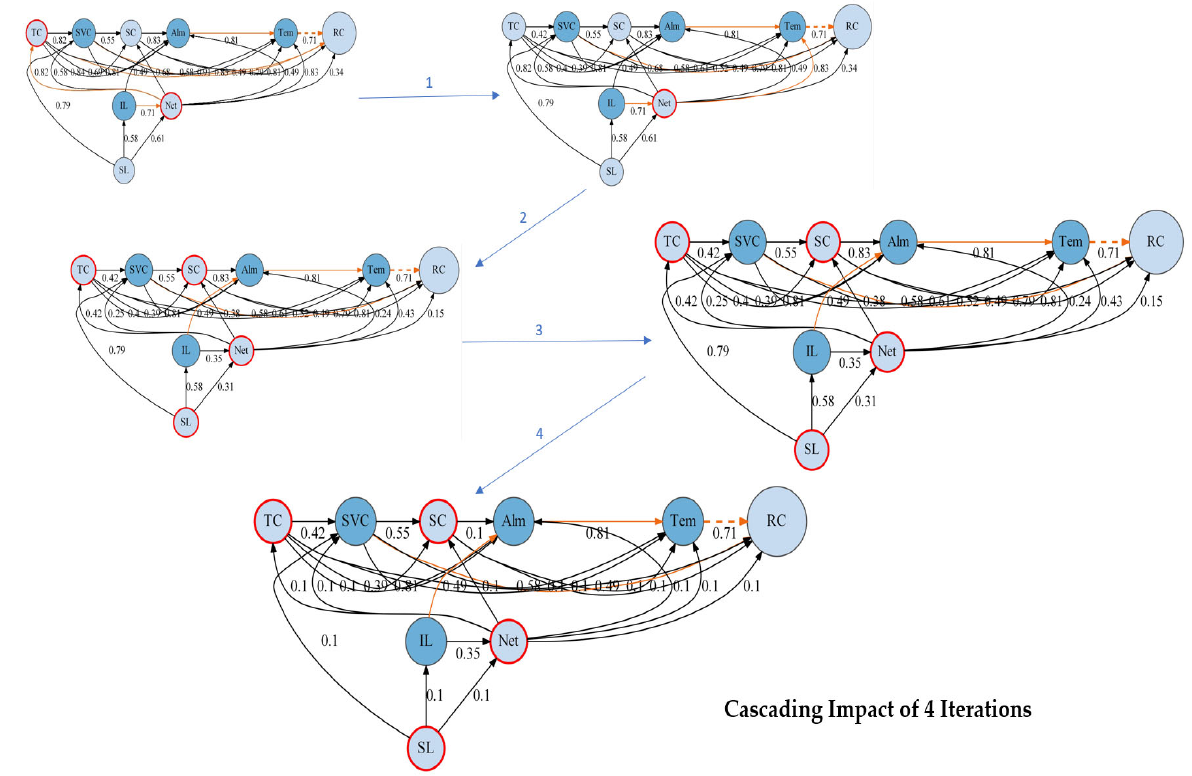
Figure 6. Changes to critical nodes and paths with the execution of mitigation strategies.